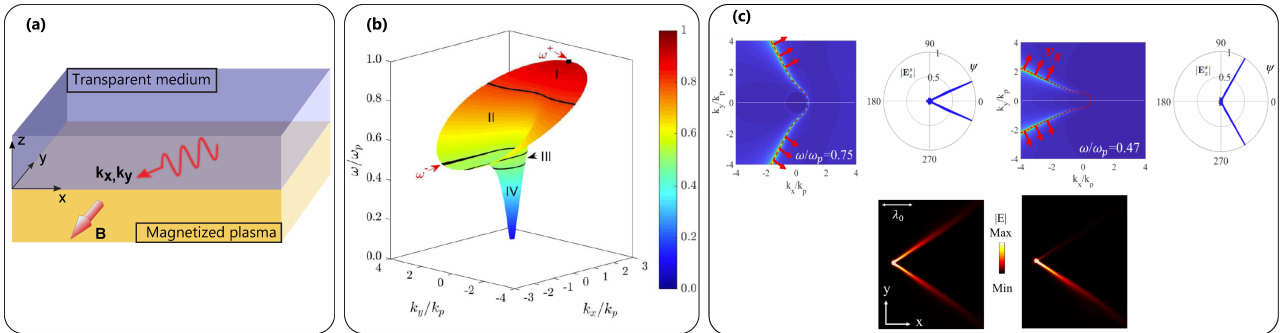
Figure 5. Surface plasmon-polariton modes in arbitrary directions on the two-dimensional interface between a magnetized plasmonic material and a transparent medium. ( a ) Three-dimensional geometry under consideration with an applied magnetic field in the y-direction. ( b ) 2D dispersion diagram of the SPP mode calculated using a standard local Drude model for ω c = 0.4 ω p . The black lines are the equifrequency contours at select frequencies. ( c ) Top: Equifrequency contours in wavevector space and corresponding SPP propagation patterns (for z -directed point source excitation) in the plane of the interface. Arrows indicate the group velocity of the dominant components of the SPP mode. Two diffraction-less beams are present on the interface at frequencies within the unidirectional window in ( b ). Bottom: Simulated SPP propagation patterns excited by a z -directed linearly polarized (left) and circularly polarized (right) dipole. Since the two beams have nearly orthogonal transverse spins, a suitably oriented circularly polarized dipole source can be used to strongly excite only one of the beams. ( b , c ) reproduced with permission from [58,59], respectively.